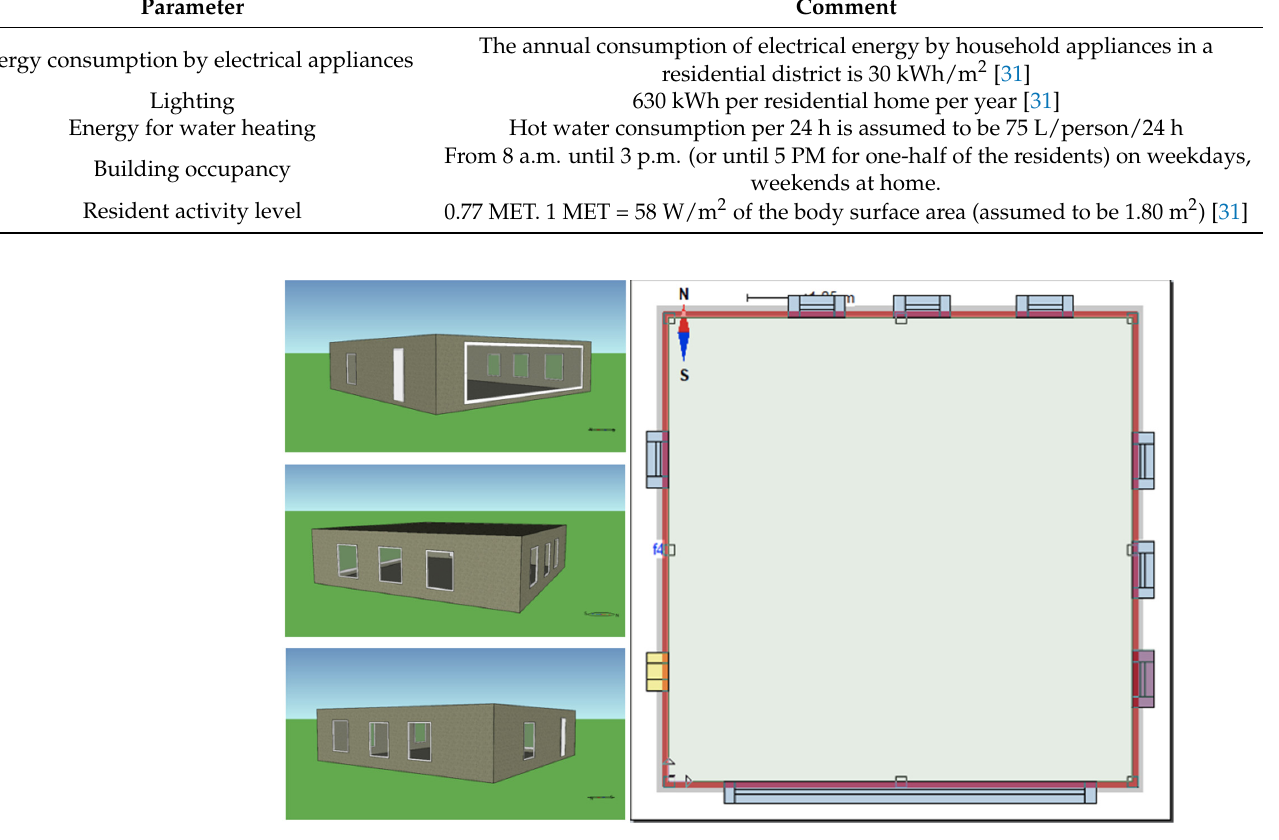
Figure 3. Visualization of the modeled residential home in the environment of IDA-ICE software.